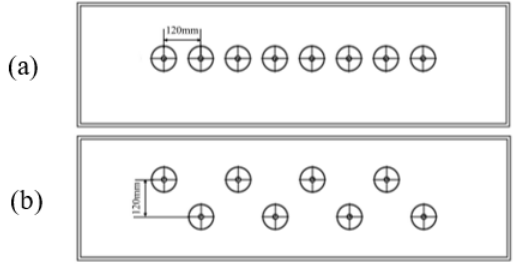
Figure 6. Lance arrangement design: ( a ) SA; ( b ) DA.